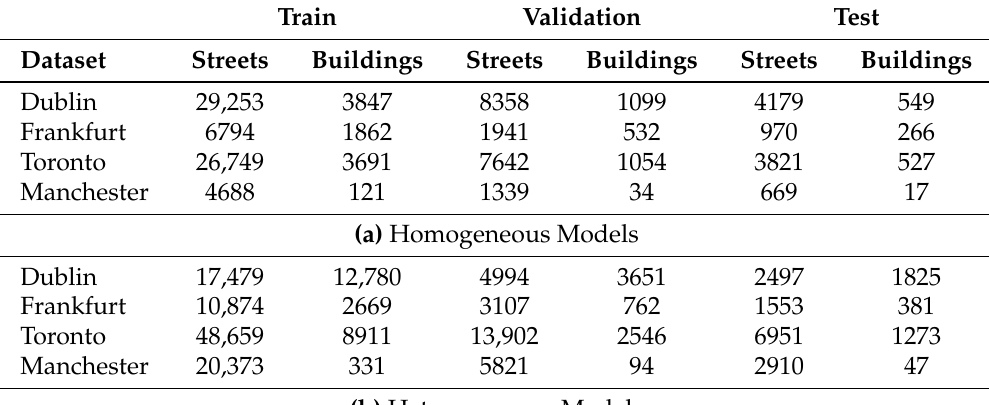
Table 3. Data Split for the homogeneous and heterogeneous models. The train split shown here is 70% of the entire